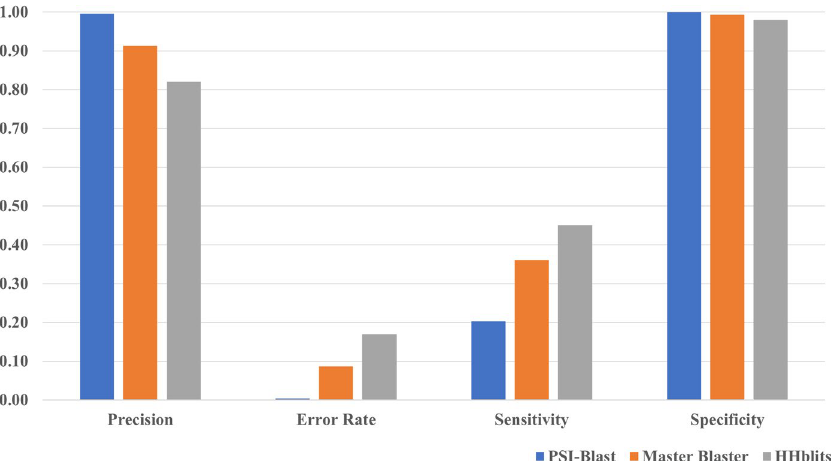
Figure 4. Comparative assessment of PSI-BLAST, Master Blaster and HHblits using Sensitivity, Specificity, Precision and Error rate as performance metrics. Performance of PSI-BLAST is represented in Blue, Master Blaster in Orange and HHblits in Grey